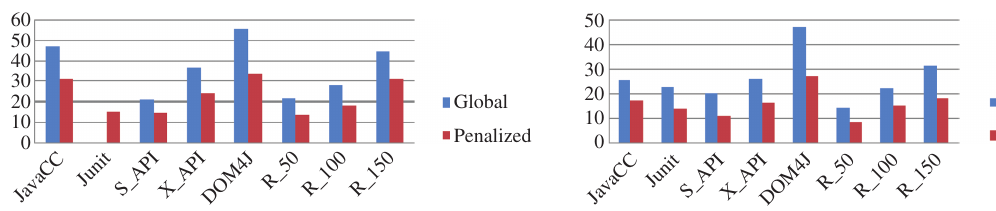
Figure 4: Percentage of Class Movement in Global and Penalized